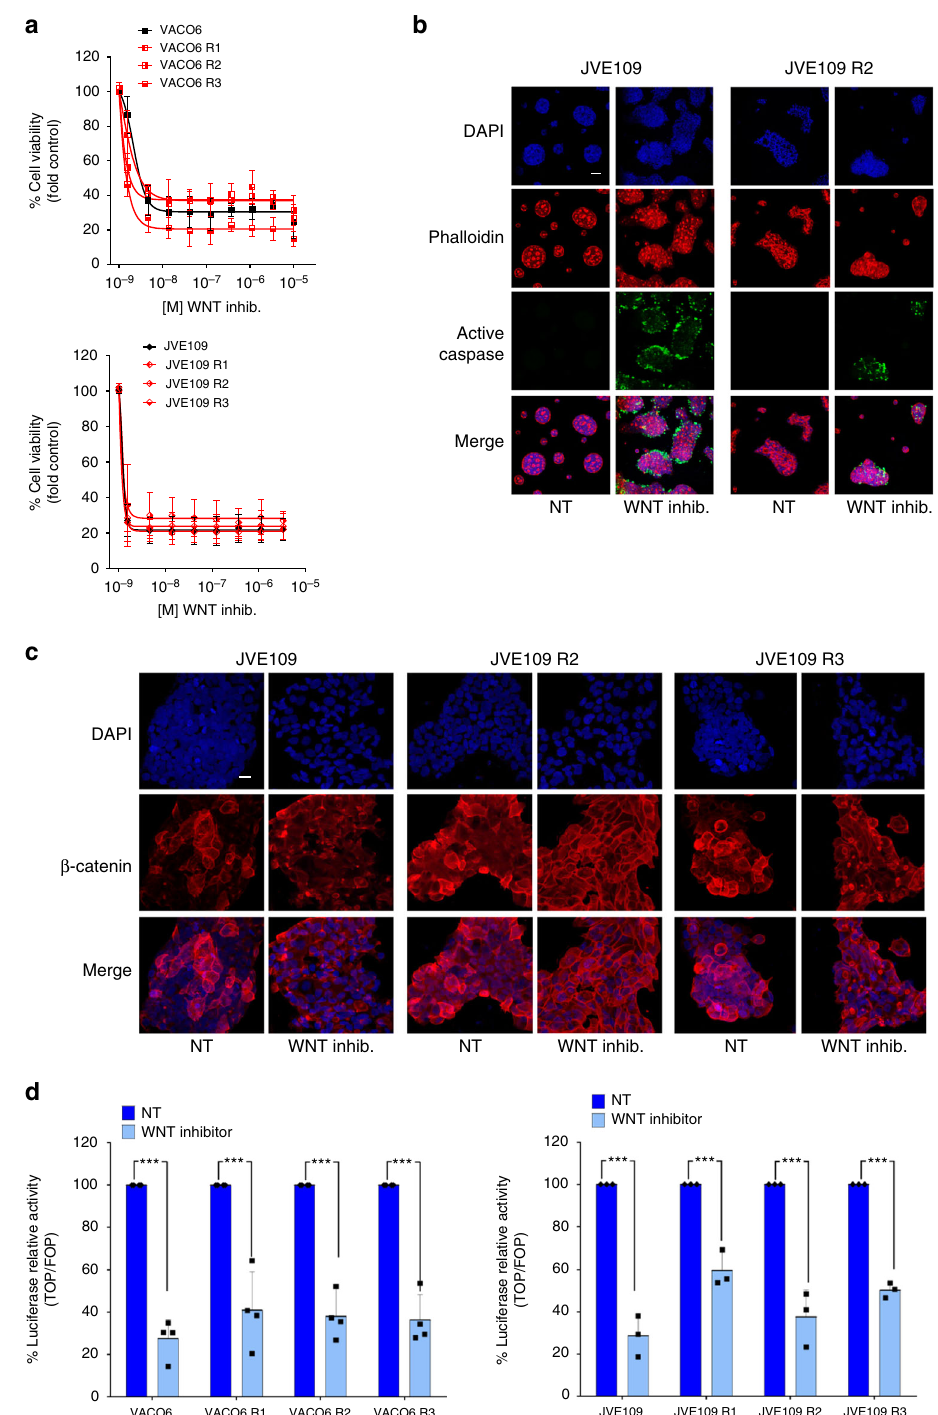
Fig. 4 Pharmacological blockade of WNT signalling is effective in molecularly heterogeneous populations of drug-resistant CRC cells. a BRAF-mutated VACO6 and JVE109 CRC cells were treated for 5 days with increasing concentrations of porcupine inhibitor LGK974 (WNT inhib.). Cell viability was assayed by the ATP assay. Data points represent means ± SD of at least three independent experiments. b JVE109 parental and resistant-derivatives cells were treated with LGK974 for 5 days. After that, active cleaved caspase-3 was detected by immuno fl uorescence (green). Nuclei are stained with DAPI (blue) and actin with Phalloidin (red). Scale bar: 50 μ m. c JVE109 parental and resistant-derivatives cells were treated with LGK974 for 4 days. Representative confocal microscopy images showing β ‐ catenin distribution (red) are reported. Nuclei are stained with DAPI (blue). Scale bar: 25 μ m. d WNT inhibitor LGK974 induces a strong downregulation of β ‐ catenin-dependent transcriptional activity of Tcf/LEF luciferase reporter construct in CRC parental and resistant-derivatives cells. Results represent means± SD of at least two independent experiments. Single points indicate results of single experiments. *** p < 0.001 (Student ’ s t